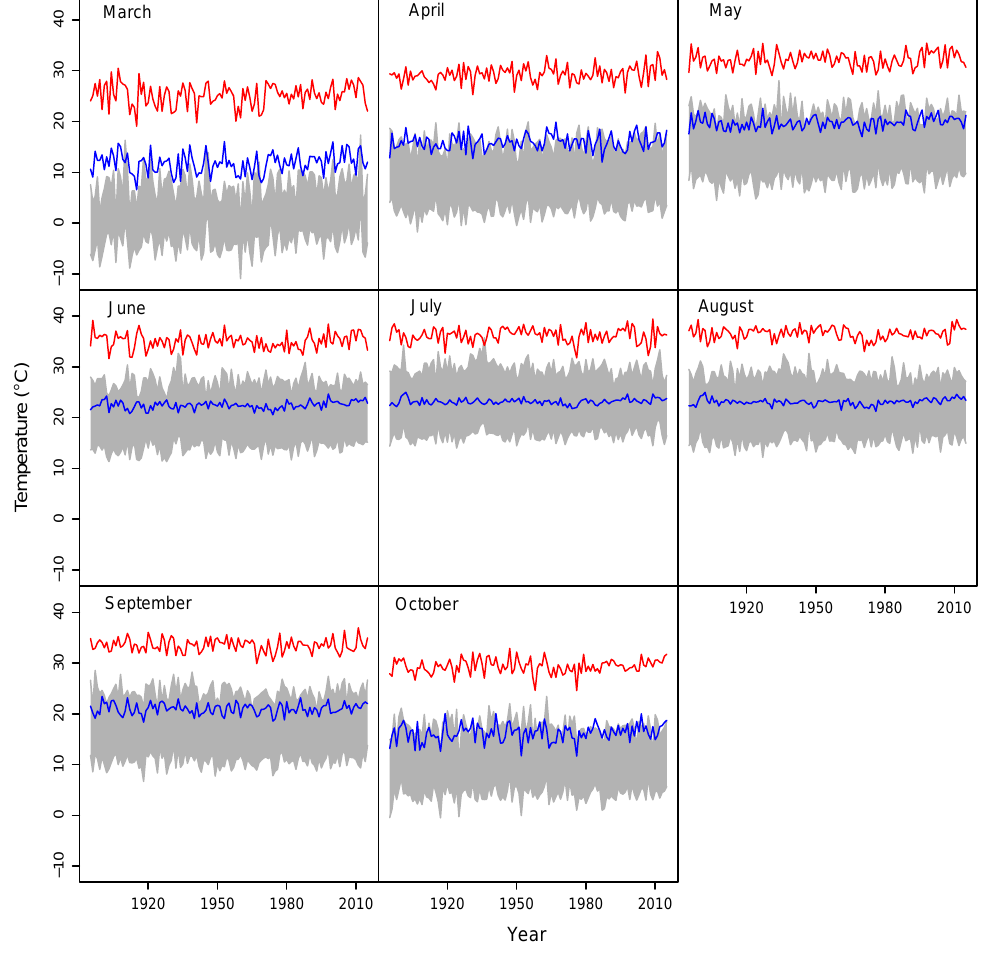
Figure 1. Time-series plots of monthly maximum and minimum temperatures at a screen height of 2 m in U.S. corn belt (upper and lower bounds, respectively, of the shaded region in grey) and in Uvalde county, Texas (red and blue lines, respectively) in March through October from 1895 to 2015. Weather data were obtained from the National Climatic Data Center [17].